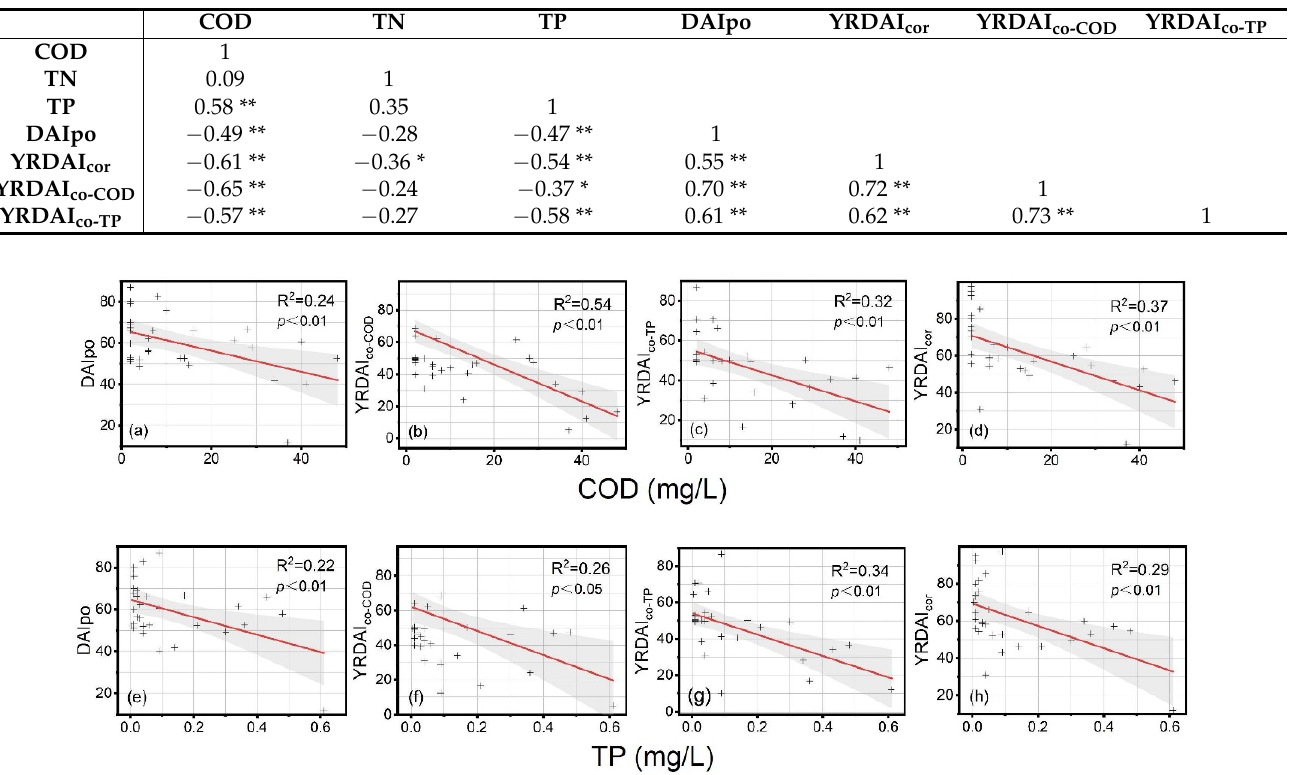
Figure 5. Relationship between COD ( a – d ) and TP ( e – h ) concentrations and the diatom indices with 95% confidence interval.